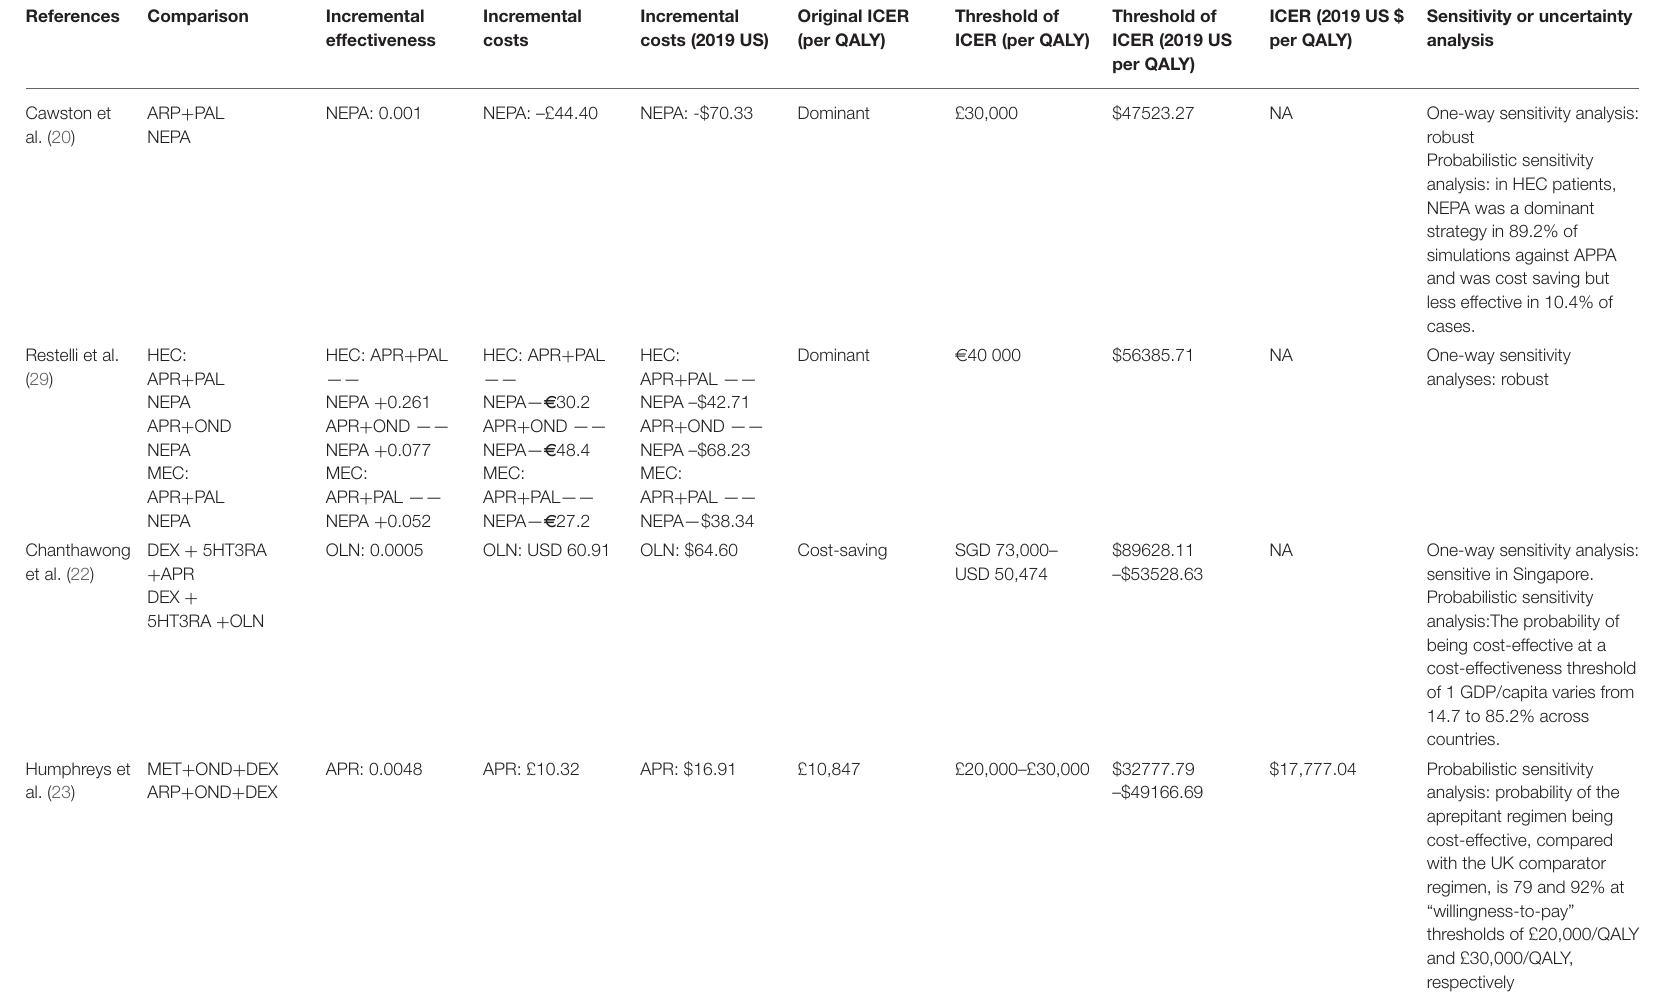
TABLE 6 | Summary of economic evaluation outcomes comparing aprepitant versus other antiemetic